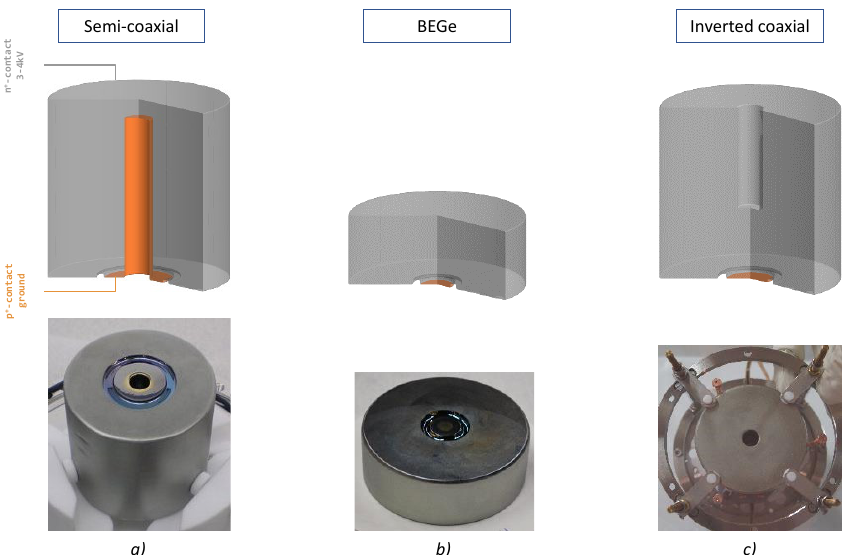
Figure 5. Sketch ( top ) and picture ( bottom ) of semi-coaxial ( a ), BEGe ( b ) and inverted coaxial ( c ) detectors employed in the various phases of the G ERDA